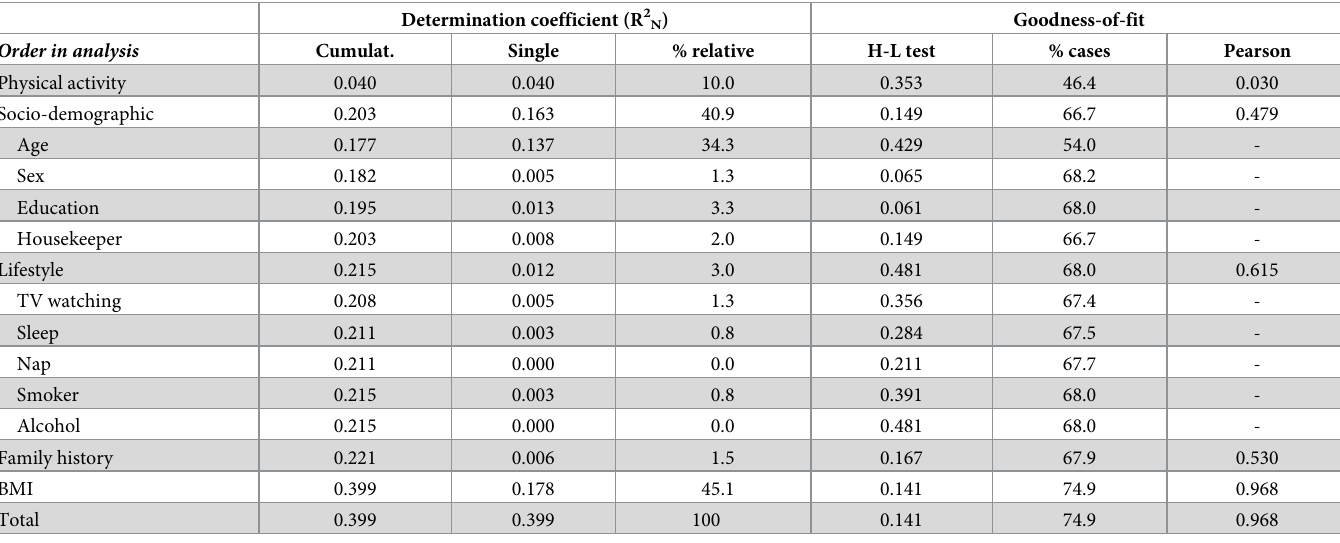
Table 3. Statistic of predictive power and goodness-of-fit test in step-by-step regression analysis.